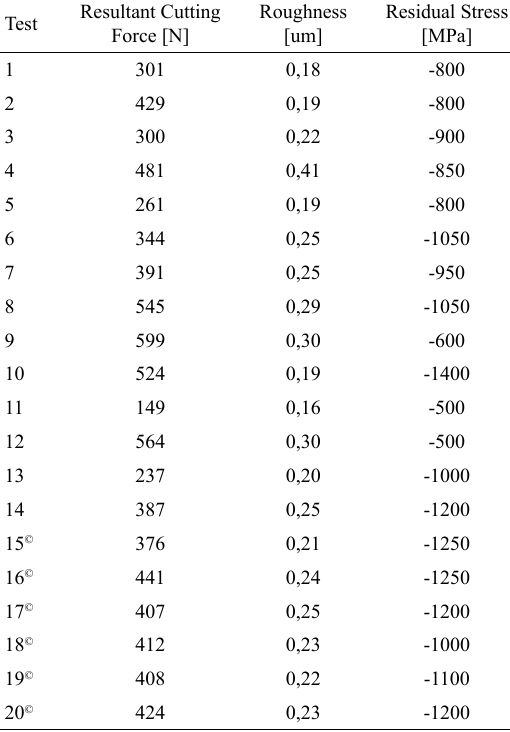
Figure 4. NLREG graphic, no linear relation of roughness vs. cutting parameters (a Table 3. Results for the residual stresses